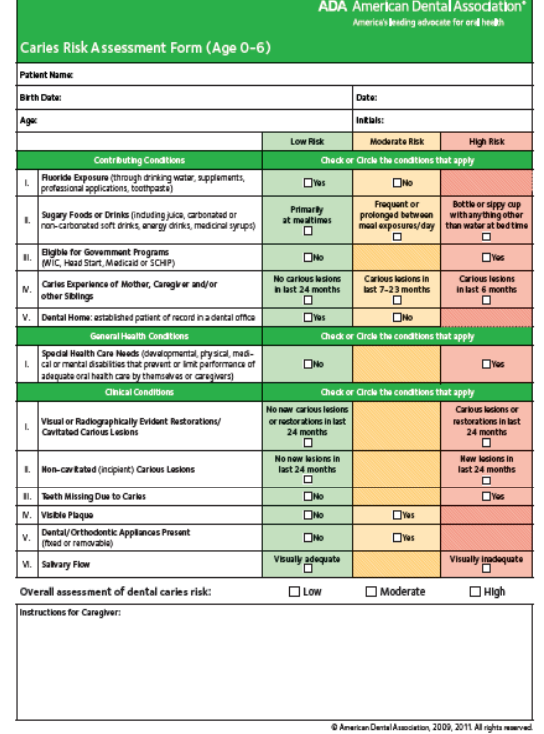
Figure 1: Caries risk assessment form. Low Risk: only conditions in the “Low-Risk” column present; Moderate Risk: only conditions in “Low” and/or “Moderate Risk” columns present; High Risk: one or more conditions in the “High Risk” column.